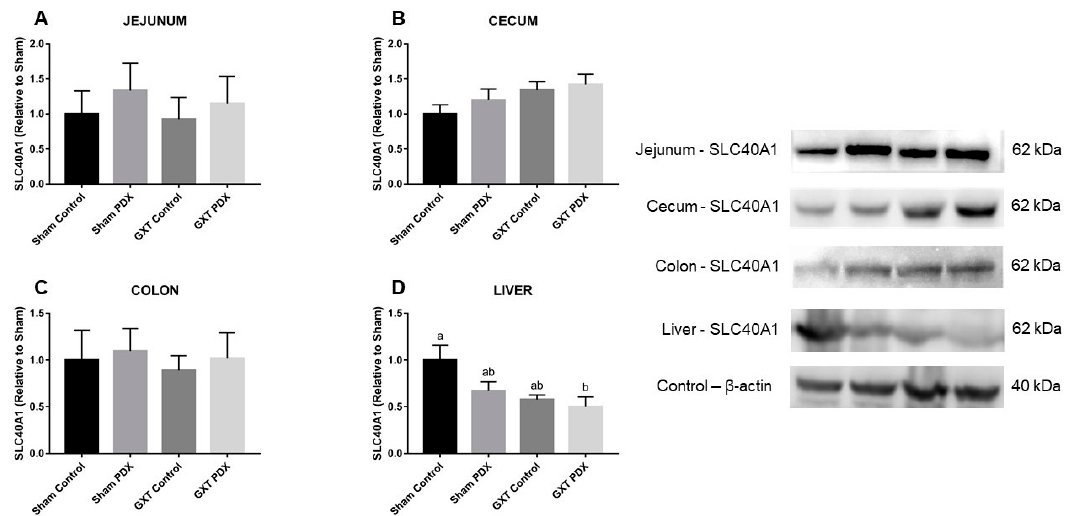
Figure 7. Expression of ferroportin in the jejunum ( A ), cecum ( B ), colon ( C ) and liver ( D ) of the animals of the experimental groups. Different letters indicate a significant difference according to Tukey’s test ( p < 0.05). Sham Control: sham without polydextrose; Sham PDX: sham with polydextrose (7.5%); GXT Control: gastrectomized without polydextrose; GXT PDX: gastrectomized with polydextrose (7.5%). Values expressed as mean ± SEM.